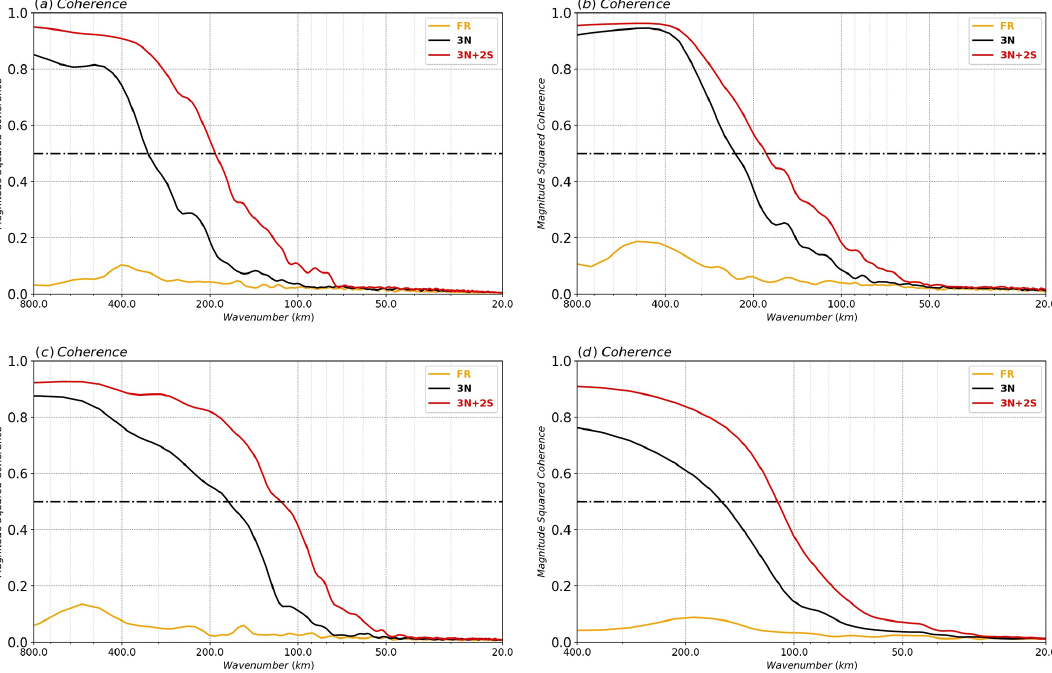
Figure 11. Wavenumber spectral coherence with respect to the NR, (a) low-latitude region (red box in Fig. 3), (b) Agulhas current (orange box in Fig. 3), (c) North Atlantic (high-latitude, green box in Fig. 3) and (d) North Atlantic Drift current (black box in Fig. 3).